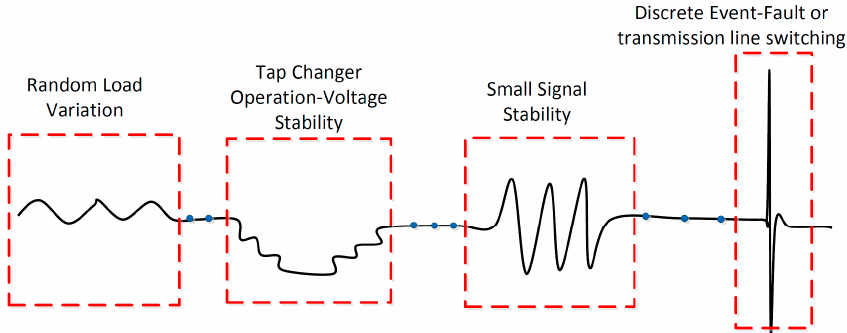
Figure 1. Signal Features at different time scale in a PMU signal.